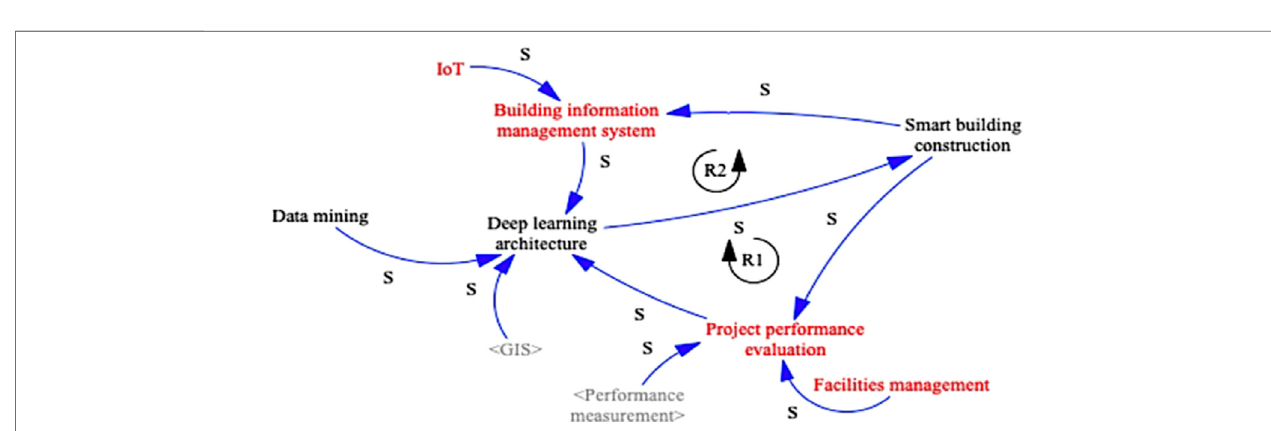
FIGURE 6 | Archetype 1- Smart campus technology and management. Source: Authors.